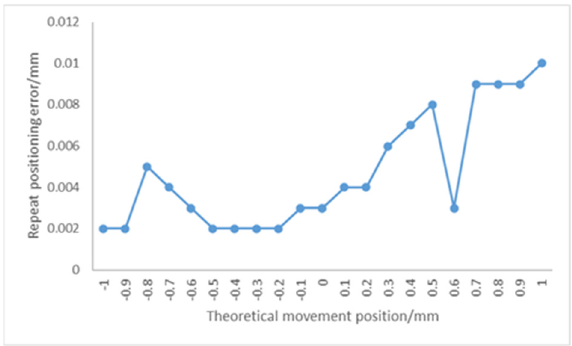
Figure 15. Repeat the positioning error in the z-direction at each position point.